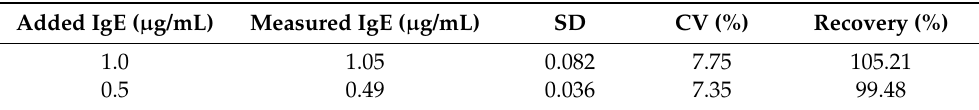
Table 2. Determination of human IgE spiked into non-diluted human serum. Based on the calibration curve (Figure S7), the concentration of human IgE in non-diluted human serum was determined using the PGM signals from unknown samples. SD, CV, and recovery are defined as standard deviation of three measurements, coefficient of variation (SD/mean × 100), and measured value/added value × 100, respectively. Added IgE ( µ g/mL) Measured IgE ( µ g/mL)